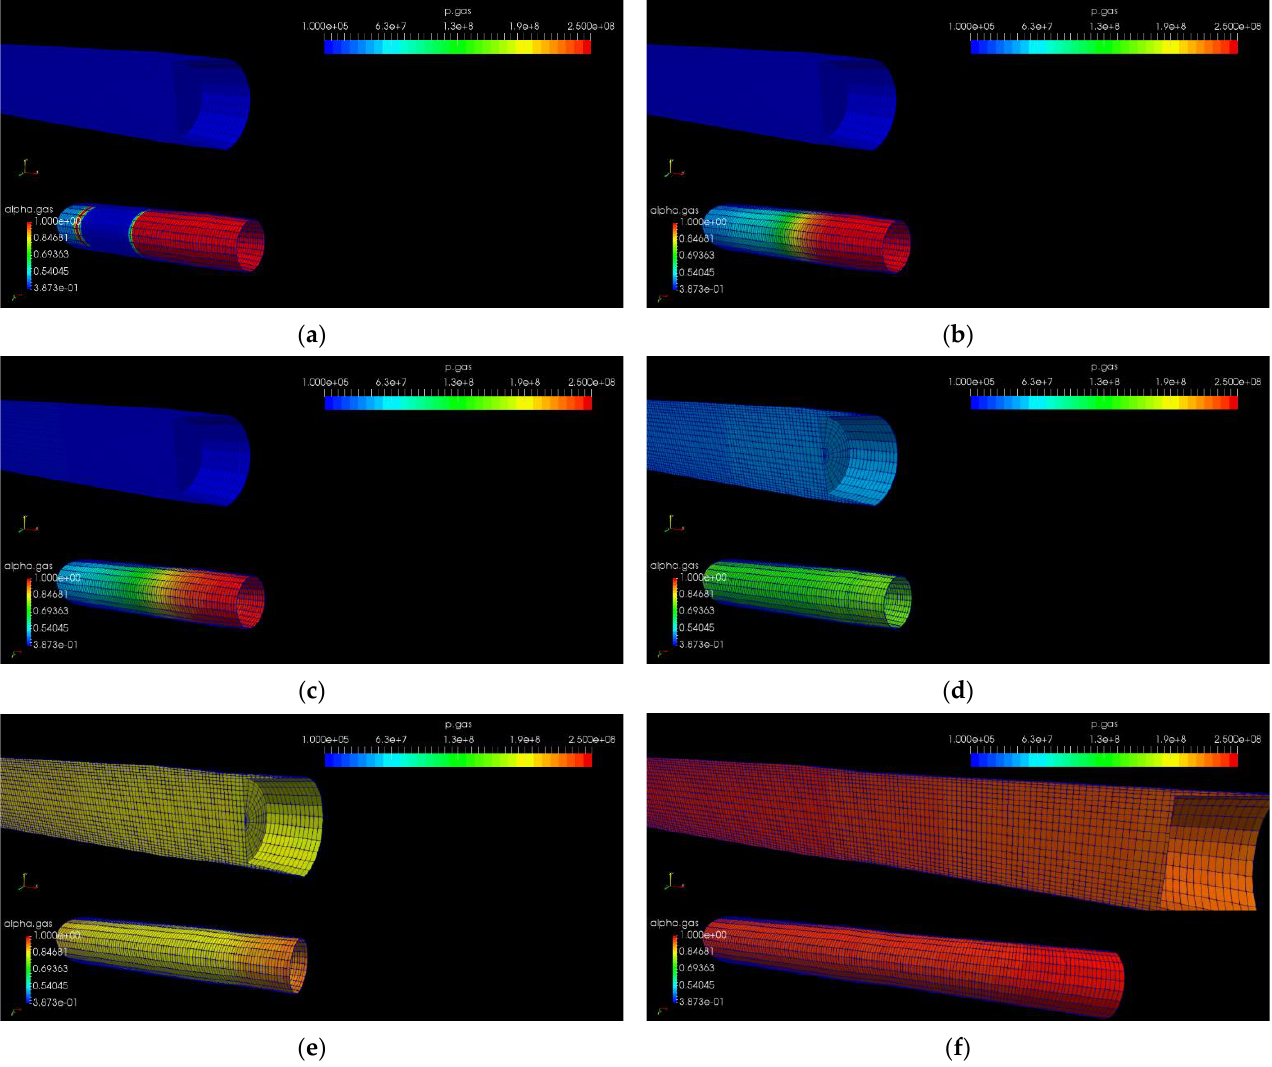
Figure 7. Computational domain cells colored by gas pressure (in Pa) and α 2 at different times. The pressure increase causes the dynamic mesh generation: ( a ) t = 0; ( b ) t = 2.6 ms; ( c ) t = 5.4 ms, ( d ) t = 7.4 ms; ( e ) t = 10.1 ms; ( f ) t = 12.0 ms.